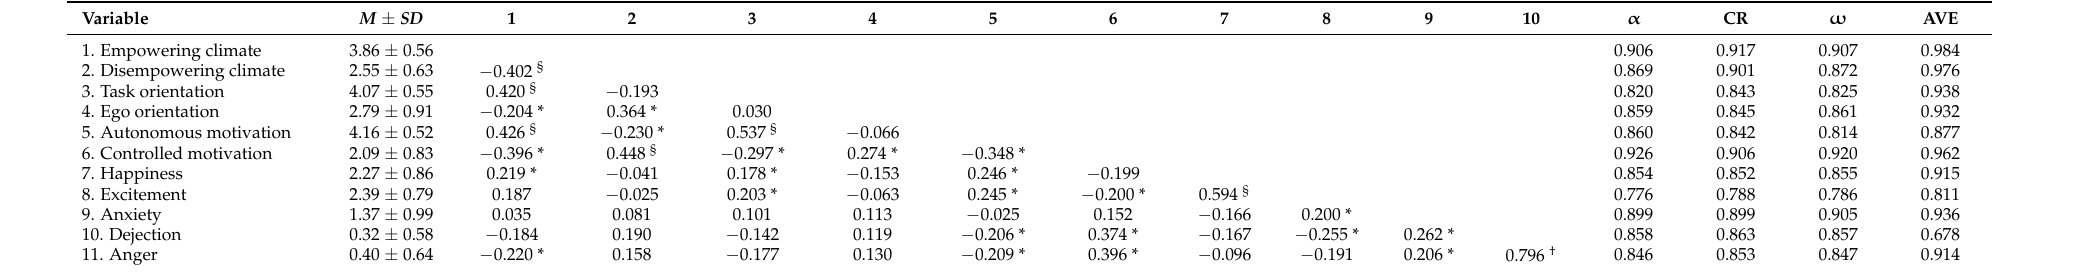
Table 1. Descriptive statistics, Pearson product-moment correlation coefficients, and reliability indices ( N = 262).